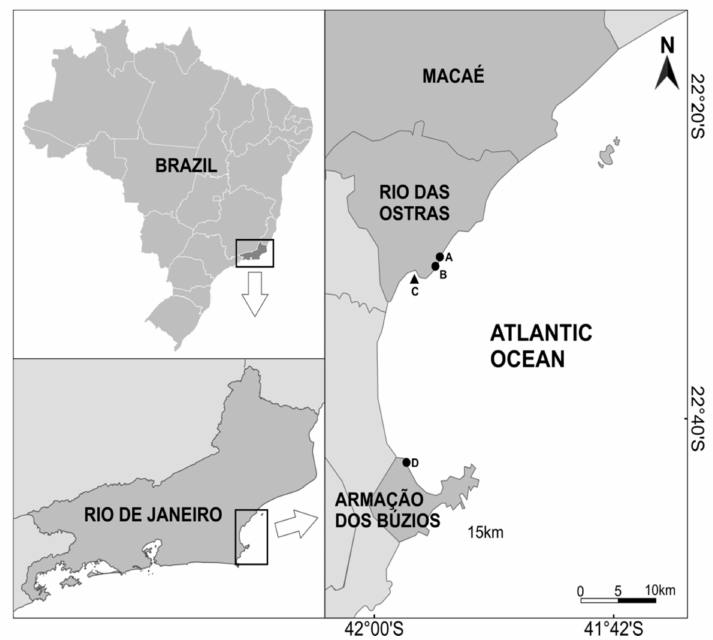
Figure 1. Map showing zooplankton sampling sites in the Rio de Janeiro coast, SW Atlantic, with the coastal municipalities where monstrilloid copepods were collected. Dots: collection in tidepools of rocky shores. Solid triangle: collection in shallow coastal zone (<5 m depth). ( A ) Remanso beach, ( B ) Areias Negras Beach, ( C ) Cemiterio beach, ( D ) Rasa